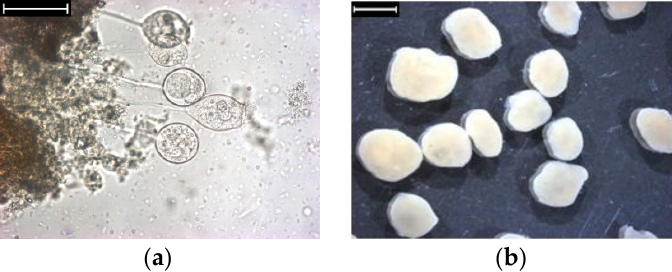
Figure 8. ( a ) Inoculum by activated sludge in SBR I. The bar represents 50 µ m. ( b ) Inoculum by aerobic granules in SBR II. The bar represents 2